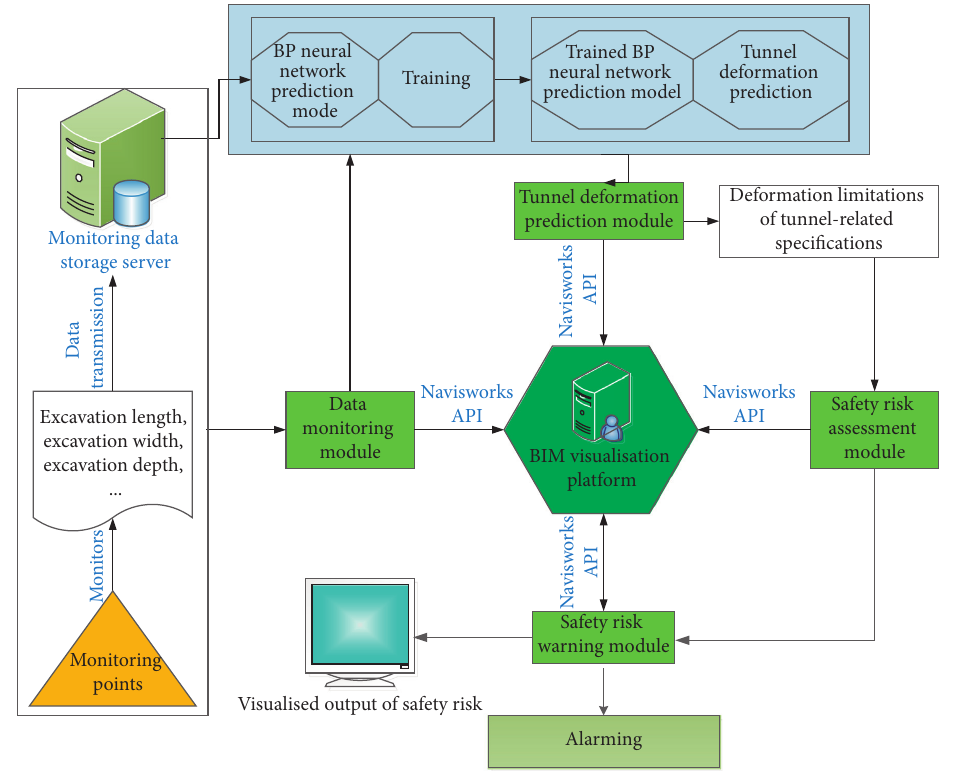
Figure 3: Operation framework for the intelligent early warning